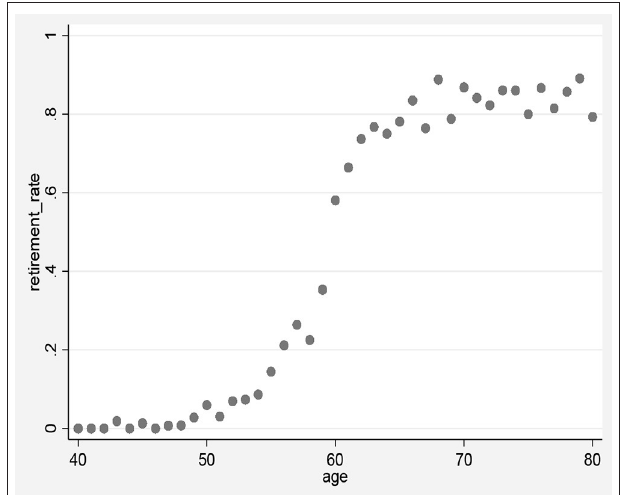
FIGURE 2 | The impact of